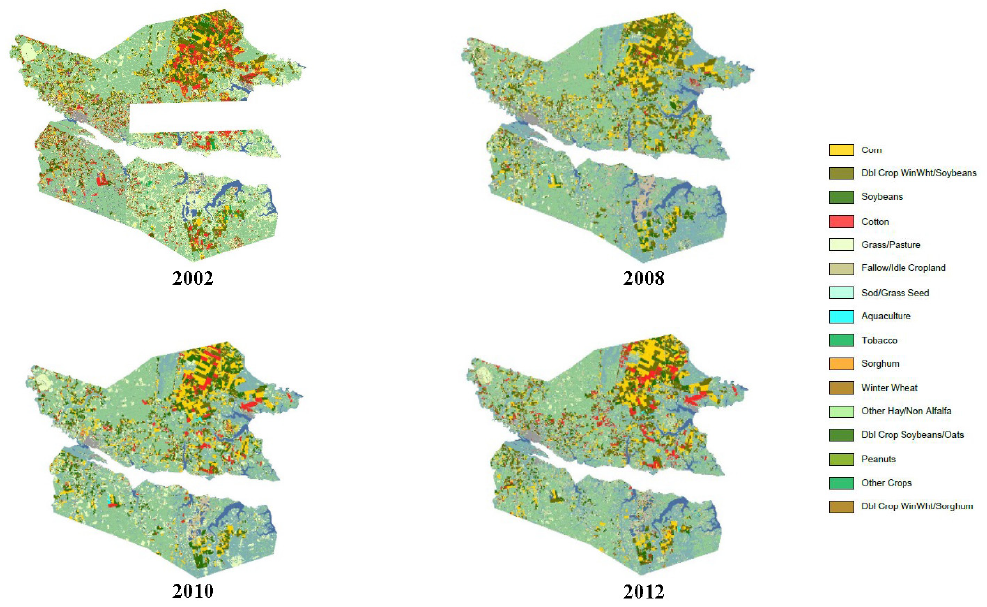
Figure 4. Beaufort County, NC agriculture land cover by crop category. Transparent sections contained no data (USDA NASS, CropScape, Cropland Data Layer).